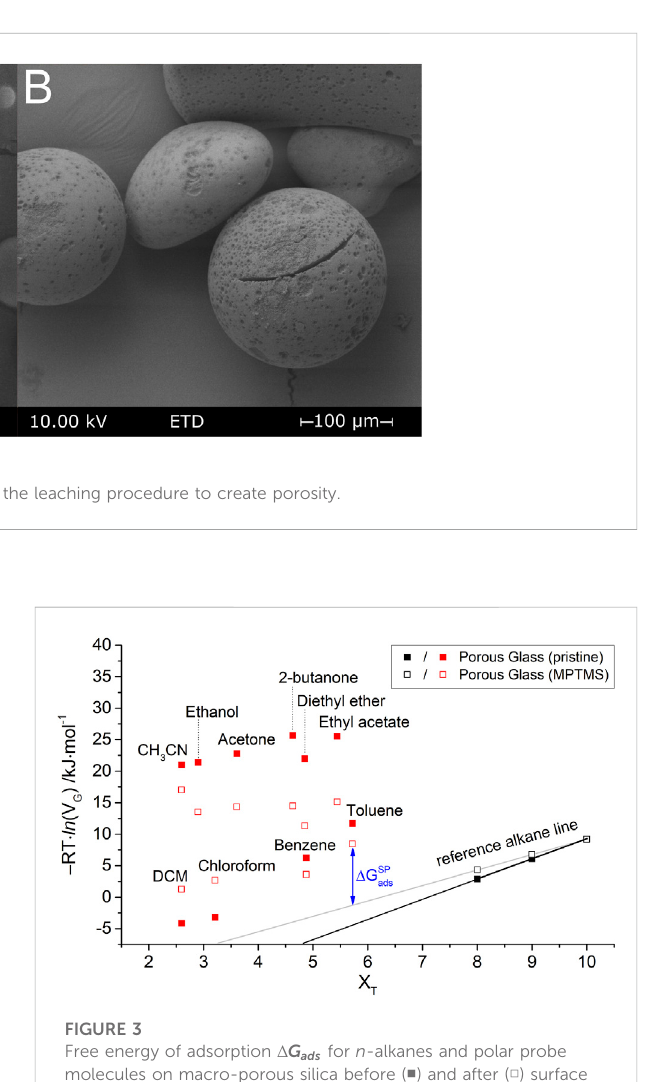
FIGURE 2 Pore distribution function for the porous silica spheres determined by mercury porosimetry showing relative and cumulative pore volumes.